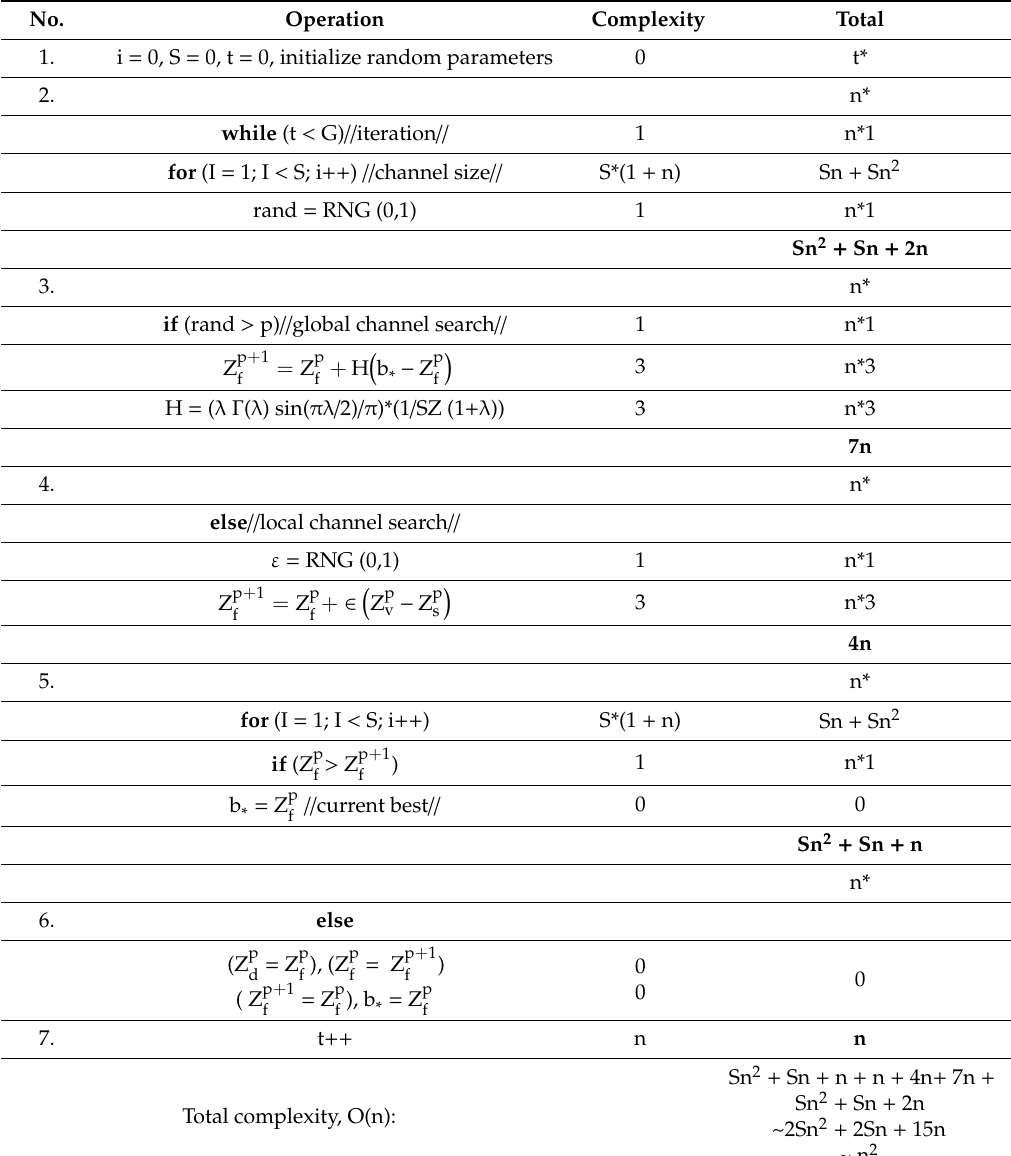
Table 2. Algorithm